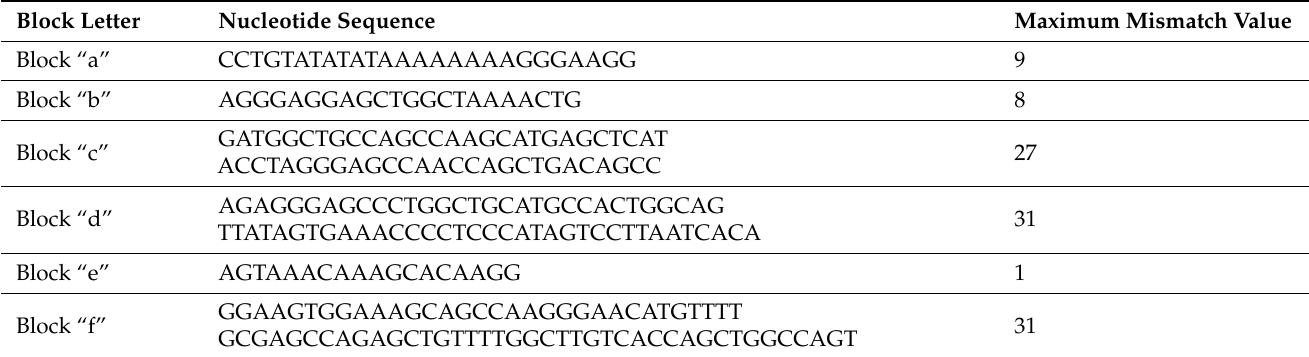
Table 3. Block sequences and criteria used to locate them in each